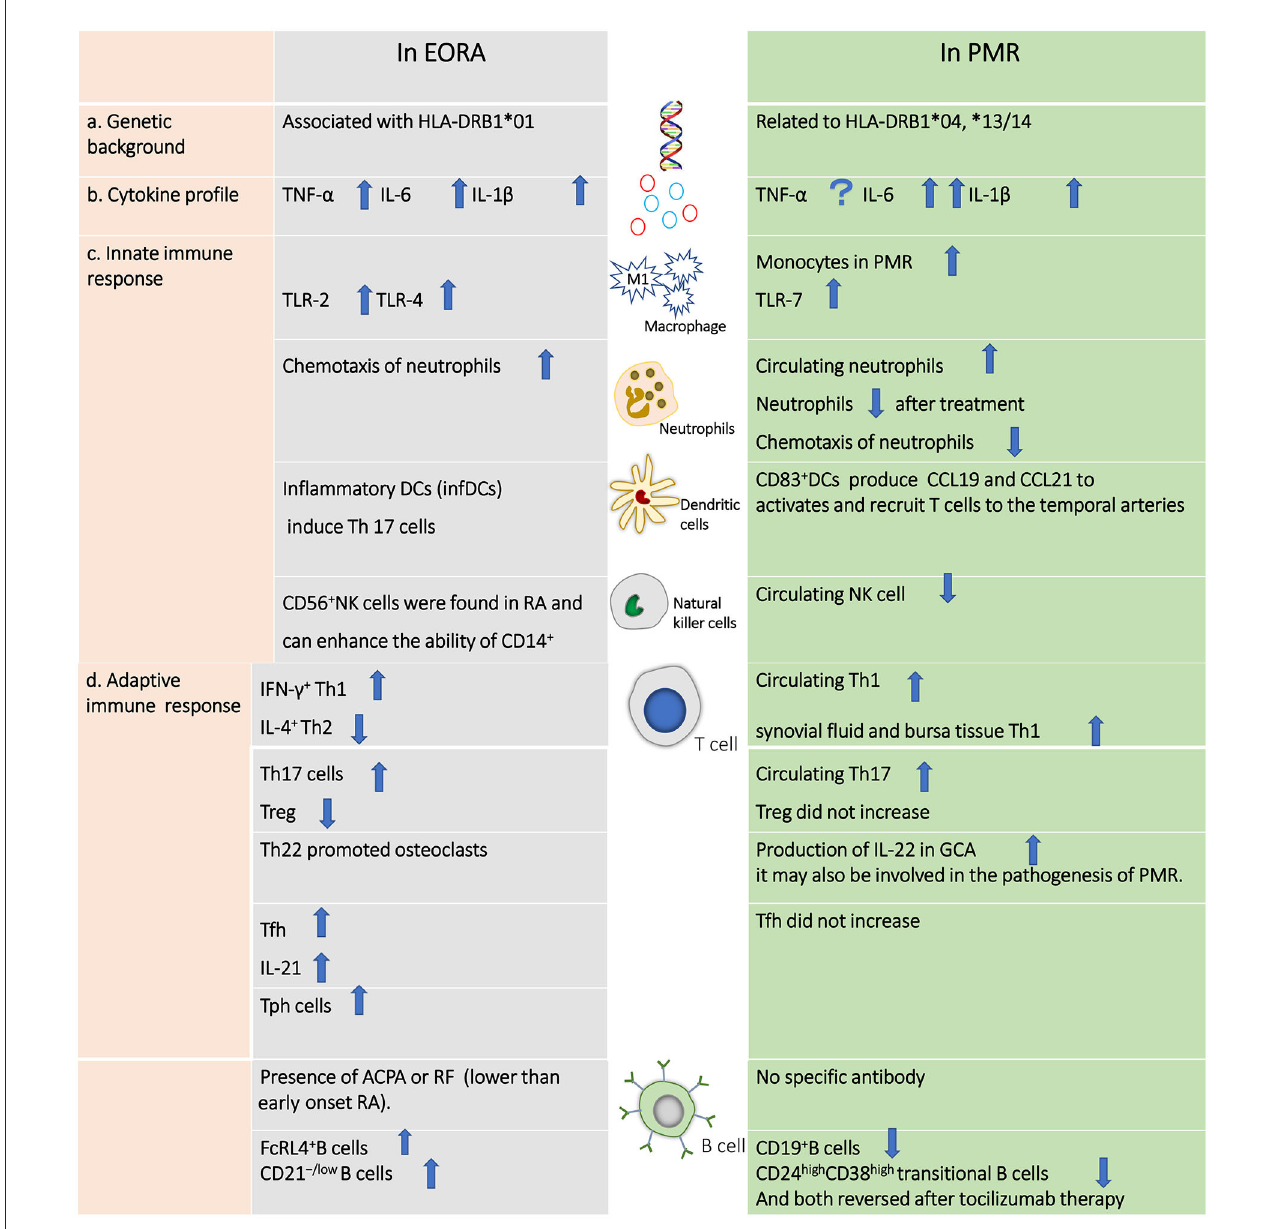
FIGURE1 Differences in the pathogenesis of elderly-onset rheumatoid arthritis vs. polymyalgia